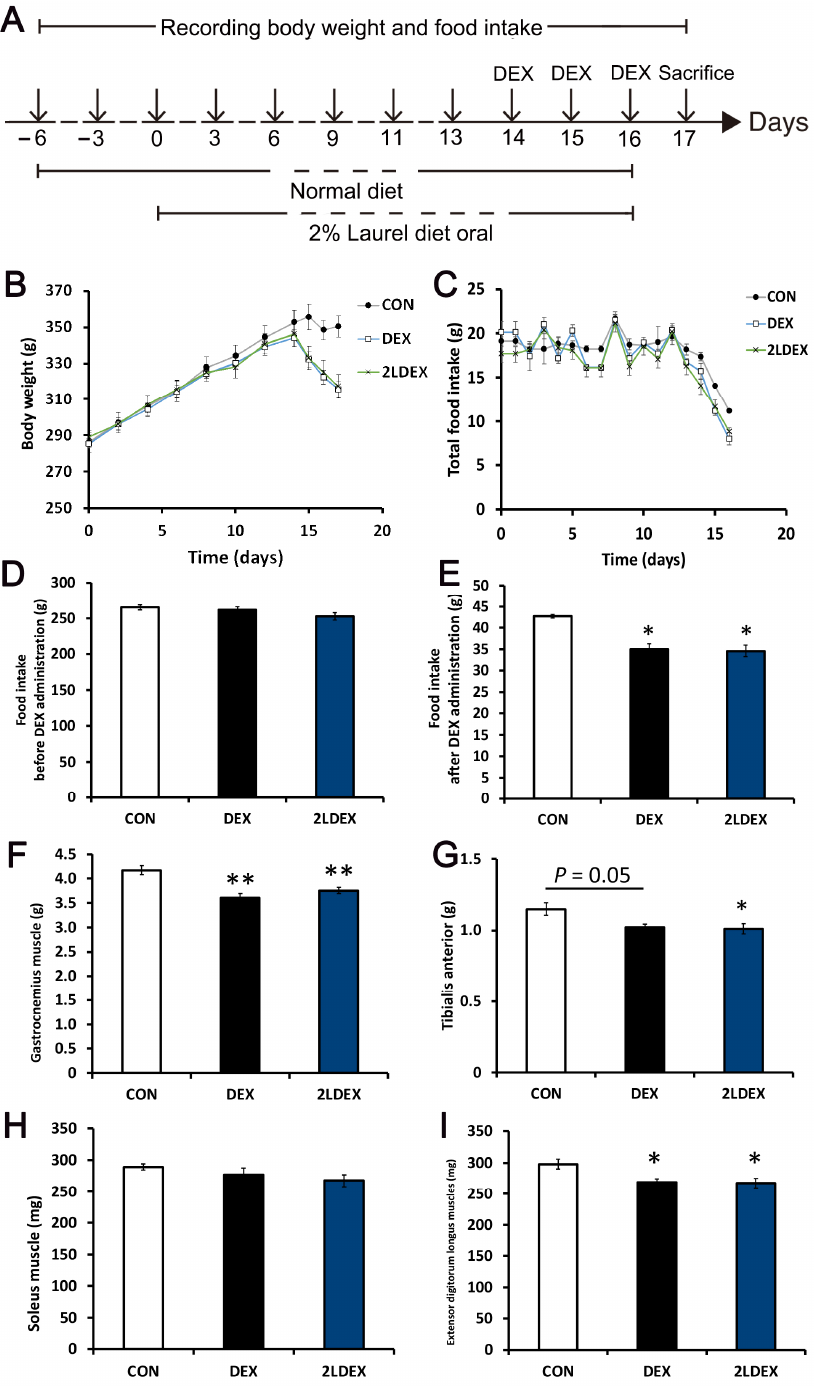
Figure 3. Effects of laurel on body weight, food intake, and muscle mass in DEX-induced skeletal muscle atrophy model rats. ( A ) Schematic representation of the animal experiment design. ( B ) Body weight during the experiment. ( C ) Total food intake of rats in three treatment groups. ( D ,E) The food intake of rats in three treatment groups before and after DEX administration. The weights of the gastrocnemius ( F ), tibialis anterior ( G ), soleus ( H ), and extensor digitorum longus ( I ) in three treatment groups. Data are shown as the mean ± SE ( n = 7). Statistical significance was evaluated by Tukey’s test. * p < 0.05, ** p < 0.01 vs. control group.